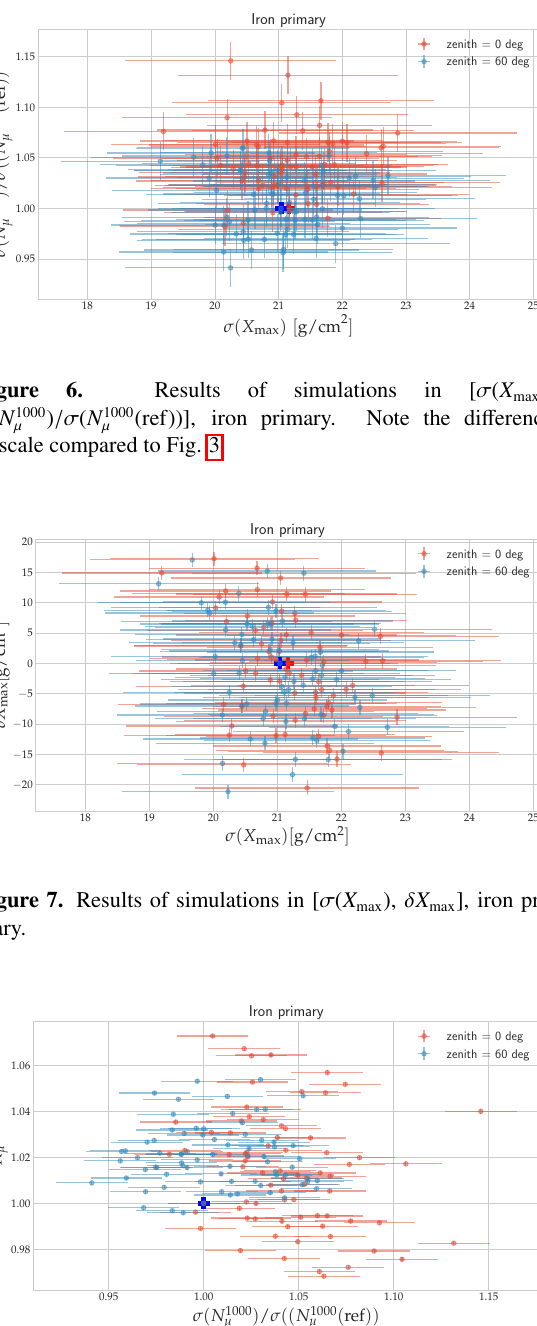
) /σ ( N 1000 (ref)), R µ ], µ µ